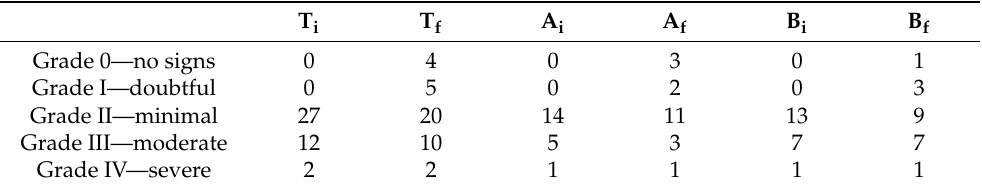
Table 4. Radiological scores according to the Kellgren and Lawrence classification before and after treatment, for the whole group of patients, group A, and group B.